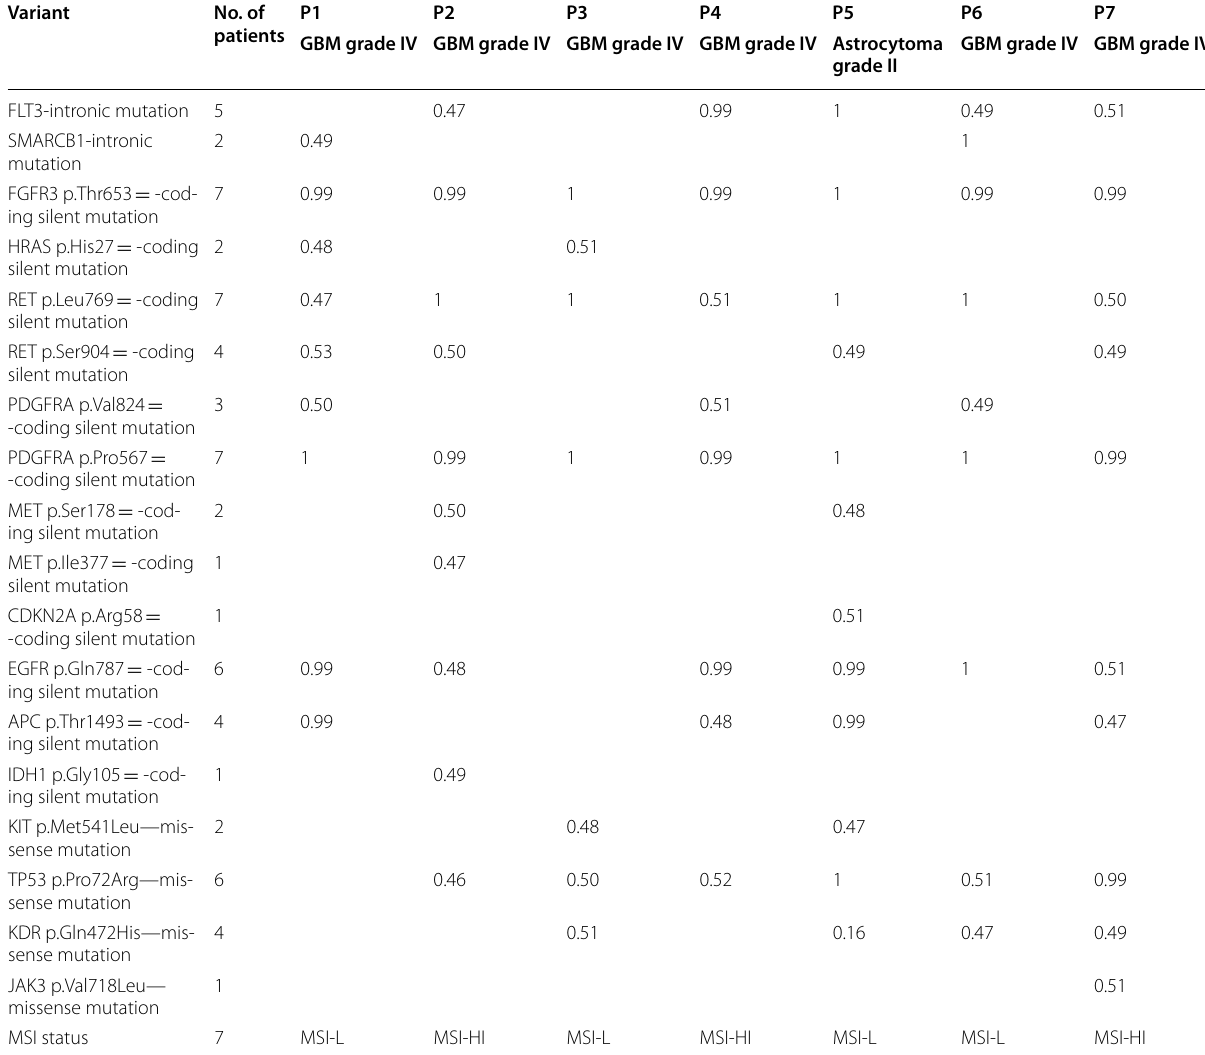
Table 2 Assessment of variant allele frequency and MSI status